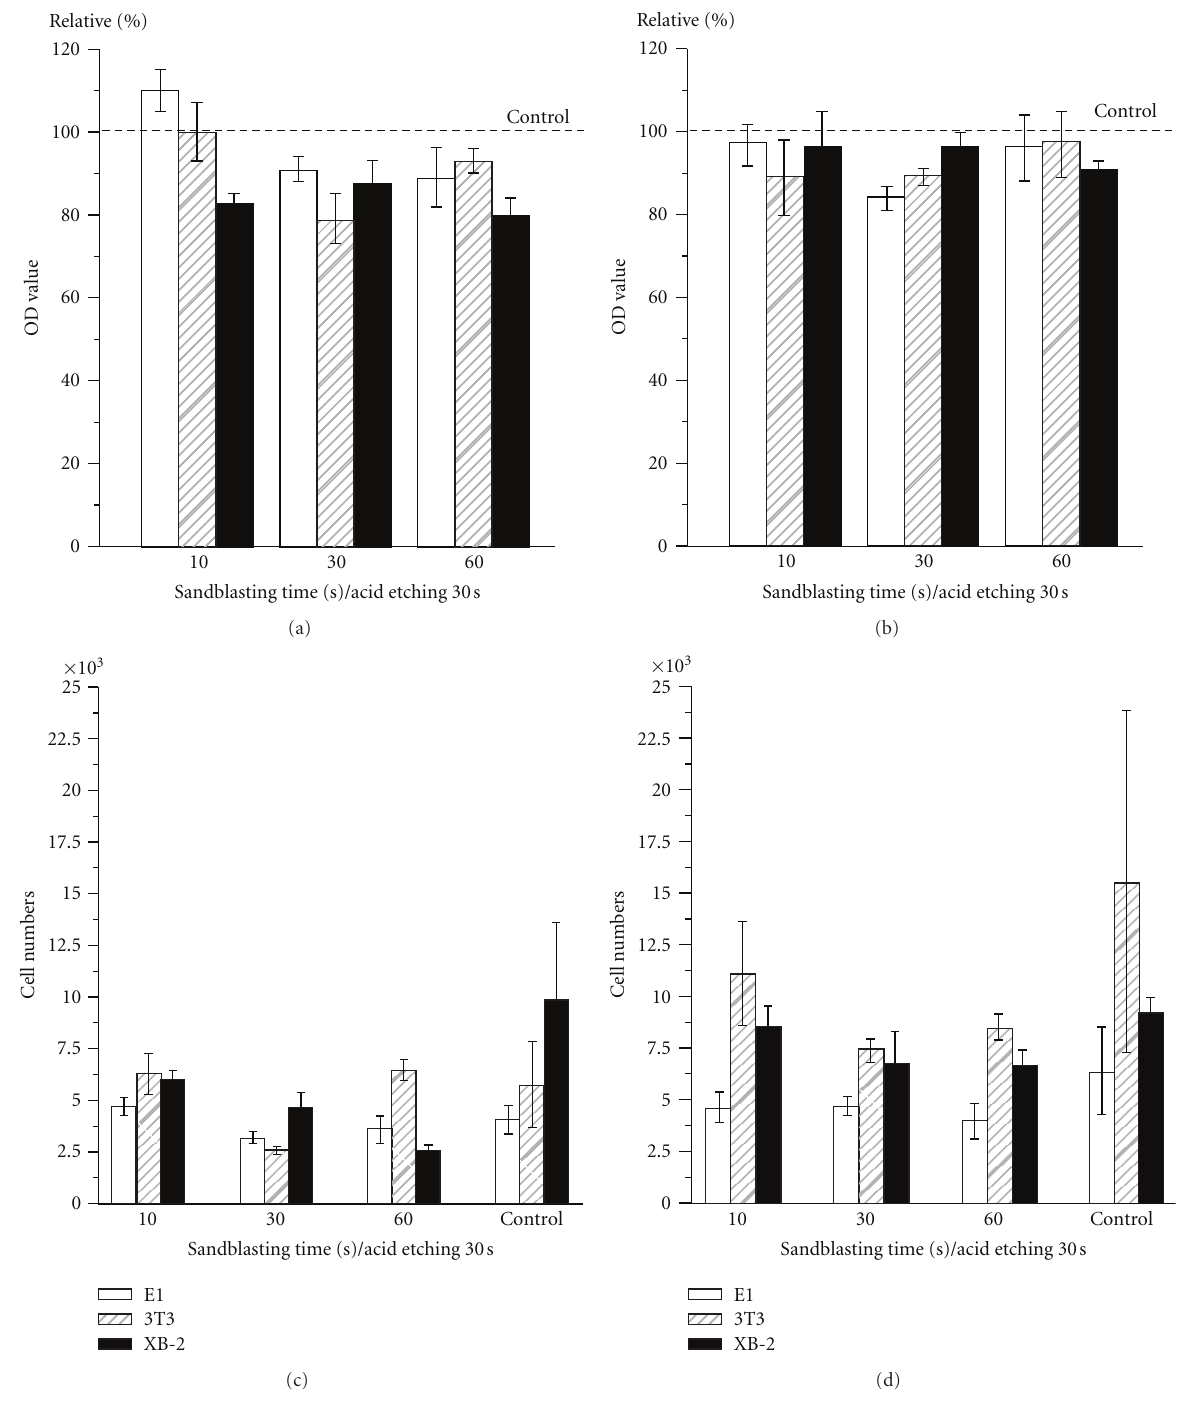
Figure 4: Di ff erent cells cultured on a variety of topographies: OD values after (a) 1h of adhesion and (b) 24 h of proliferation were compared with the control group and the cell numbers were counted after 1 h (c) and 24 h (d).